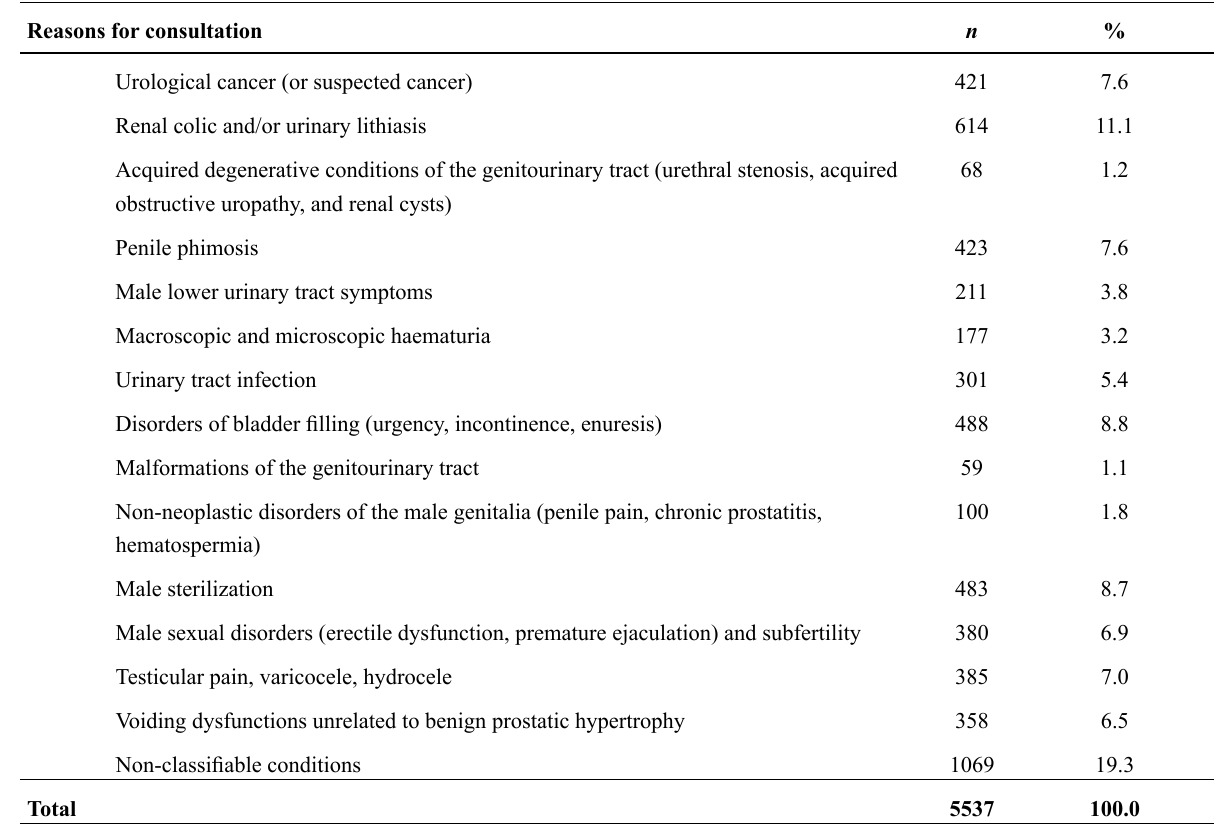
Table 1 - Reasons for consultation grouped into major syndromes.